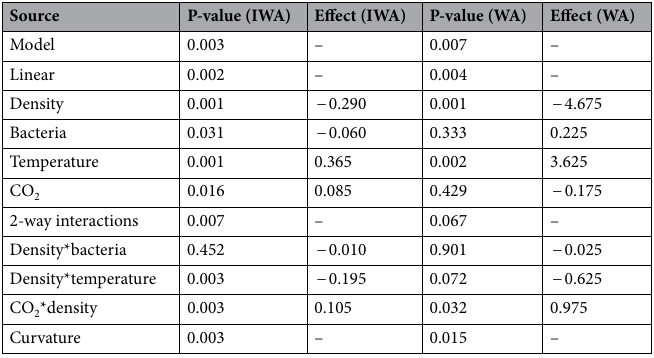
Table 2. ANOVA factorial analysis for the effect of factors and their interactions to the responses.